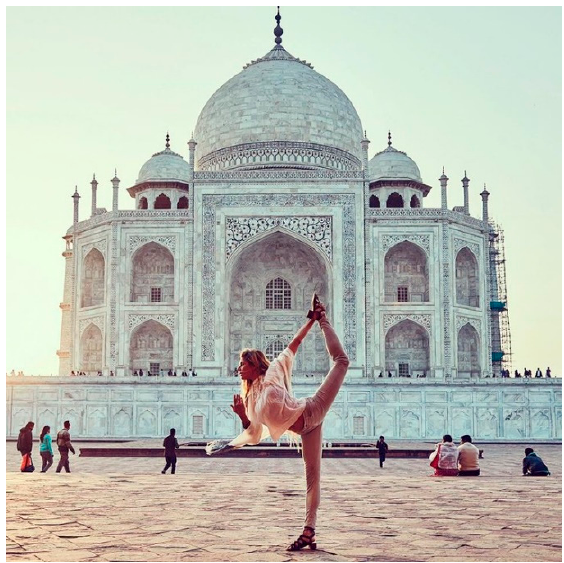
Figure 9. Tourism Advertisement for Yoga Classes at the Taj Mahal. Photo Source: https://rove.me/to/taj-mahal/yoga-classes-facing-taj-mahal.